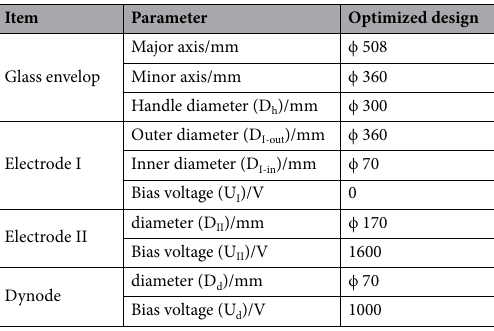
Table 2. Parameters of the optimized 20-in.